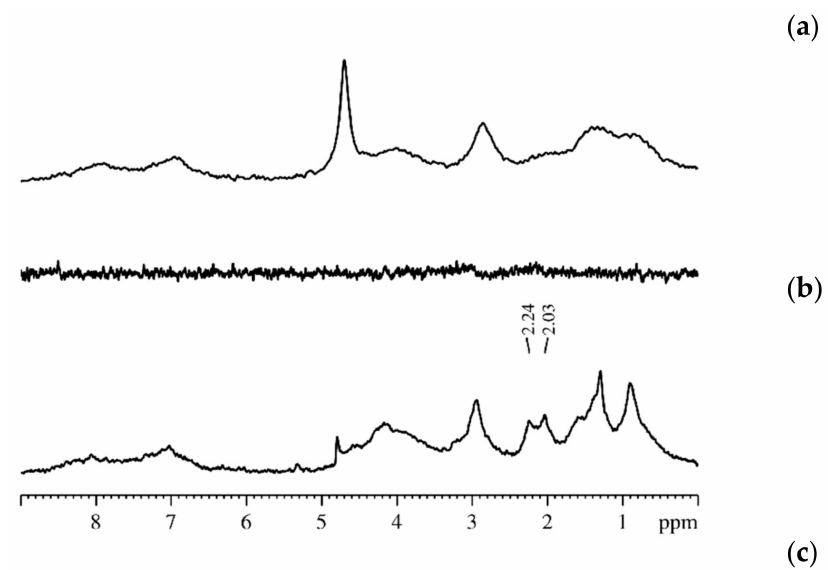
Figure 69. 1 H spin–echo NMR spectra at high gradient amplitude pulses g = 700 G/cm: ( a ) RBCs suspension; ( b ) fullerene derivative 1 in aqueous solution; ( c ) RBCs suspension with added fullerene derivative 1 . The signals of the fullerene derivative components in suspension are indicated by vertical lines. Reprinted with permission from [172]. Copyright 2018 Elsevier.